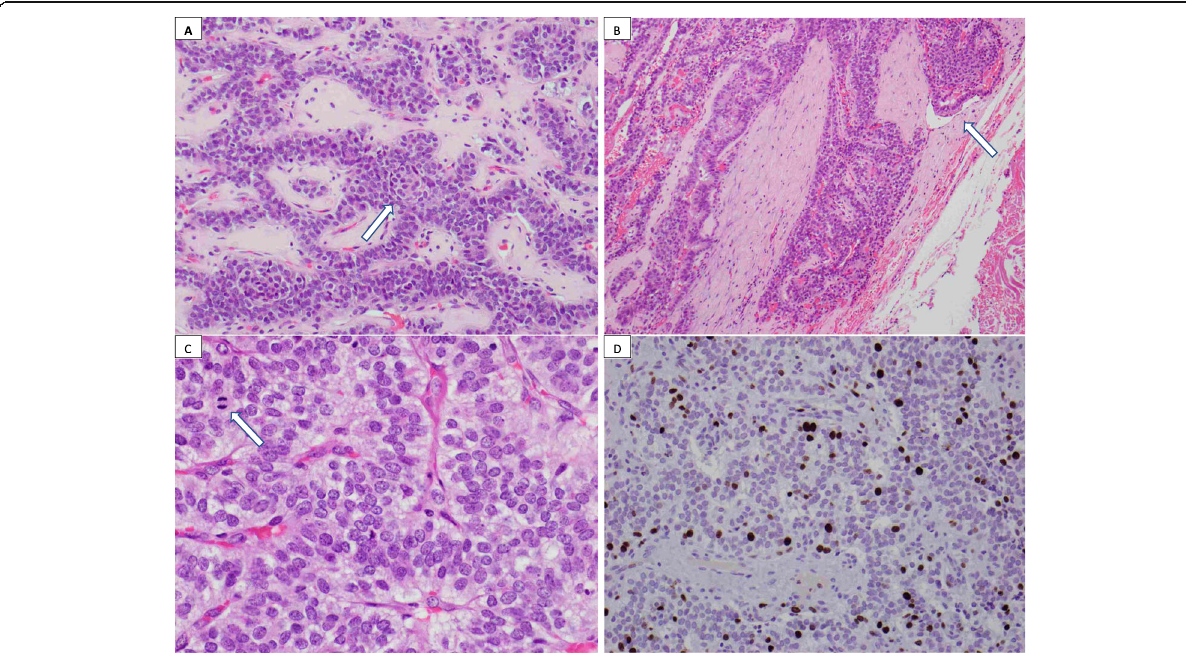
Fig. 1 Cribriform-morular variant of papillary thyroid carcinoma (CMVPTC) with dedifferentiated features. A The cribriform component of the tumor has luminal structures without colloid and prominent cribriform structures lined by stratified tall cells. A morule is also present (arrow) (X20) B Capsular invasion and a focus of tumor cells entering a blood vessel (arrow) in the capsule in the CMVPTC. (X10). Increase mitotic activity in the solid portion of the carcinoma with up to three mitoses per 10 high power field. A mitotic figure is shown (arrow). D Ki-67 immunostaining shows increased proliferative index in the solid area of the carcinoma (X40)